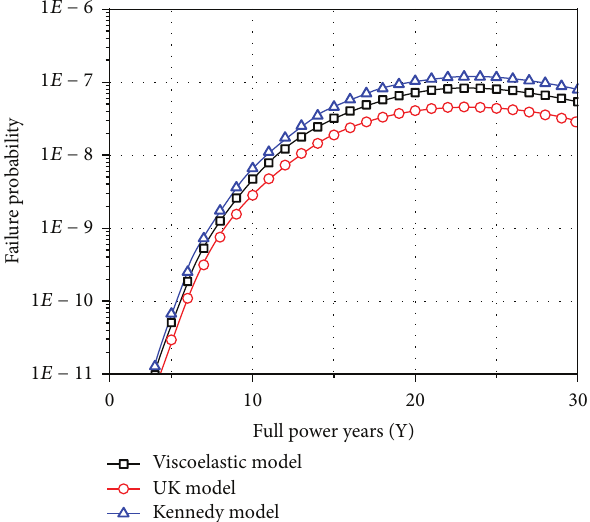
Figure 9: Failure probability history of H-451 graphite